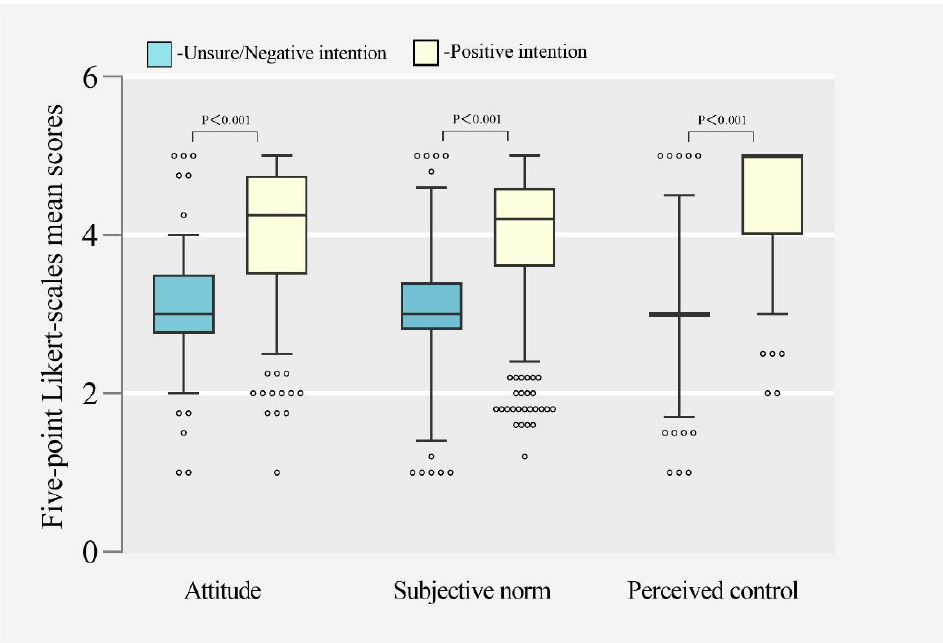
Figure 3. Box plots of five-point Likert scale mean scores of attitudes, subjective norm, and perceived control in the positive intention group and unsure/negative intention group. Data are median (central line), interquartile range (box margins), 5 – 95% percentile (whiskers), and outliers (dots).